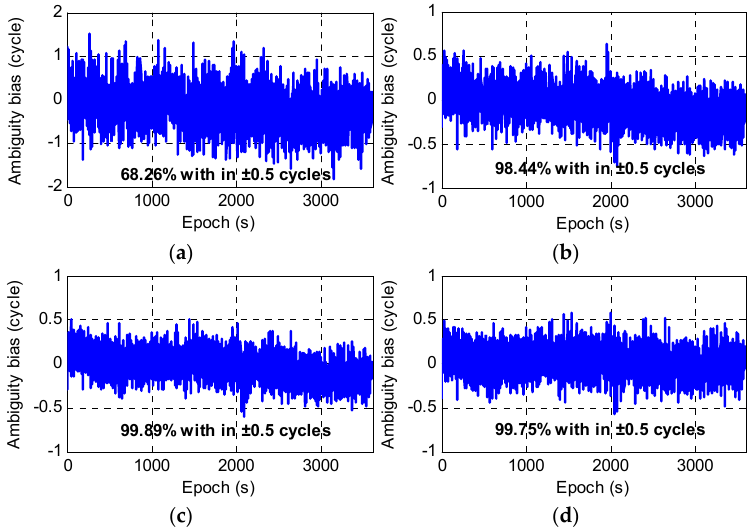
N − Δ biases with four different combined observations: ( a ) using Figure 2. Ambiguity Figure 2. Ambiguity ∆ N ( 1,4, − 5 ) biases with four different combined observations: ( a ) using observation (1,4, 5) ∆ P ∆ P observation ( 5,2,2.65) P − Δ , ( b ) using observation (1,0,0) P Δ , ( c ) using observation (0,1,1) P Δ , and ( d ) using ( − 5,2,2.65 ) ,( b )usingobservation ( 1,0,0 ) ,( c )usingobservation Δ . φ − (0, 1,1)